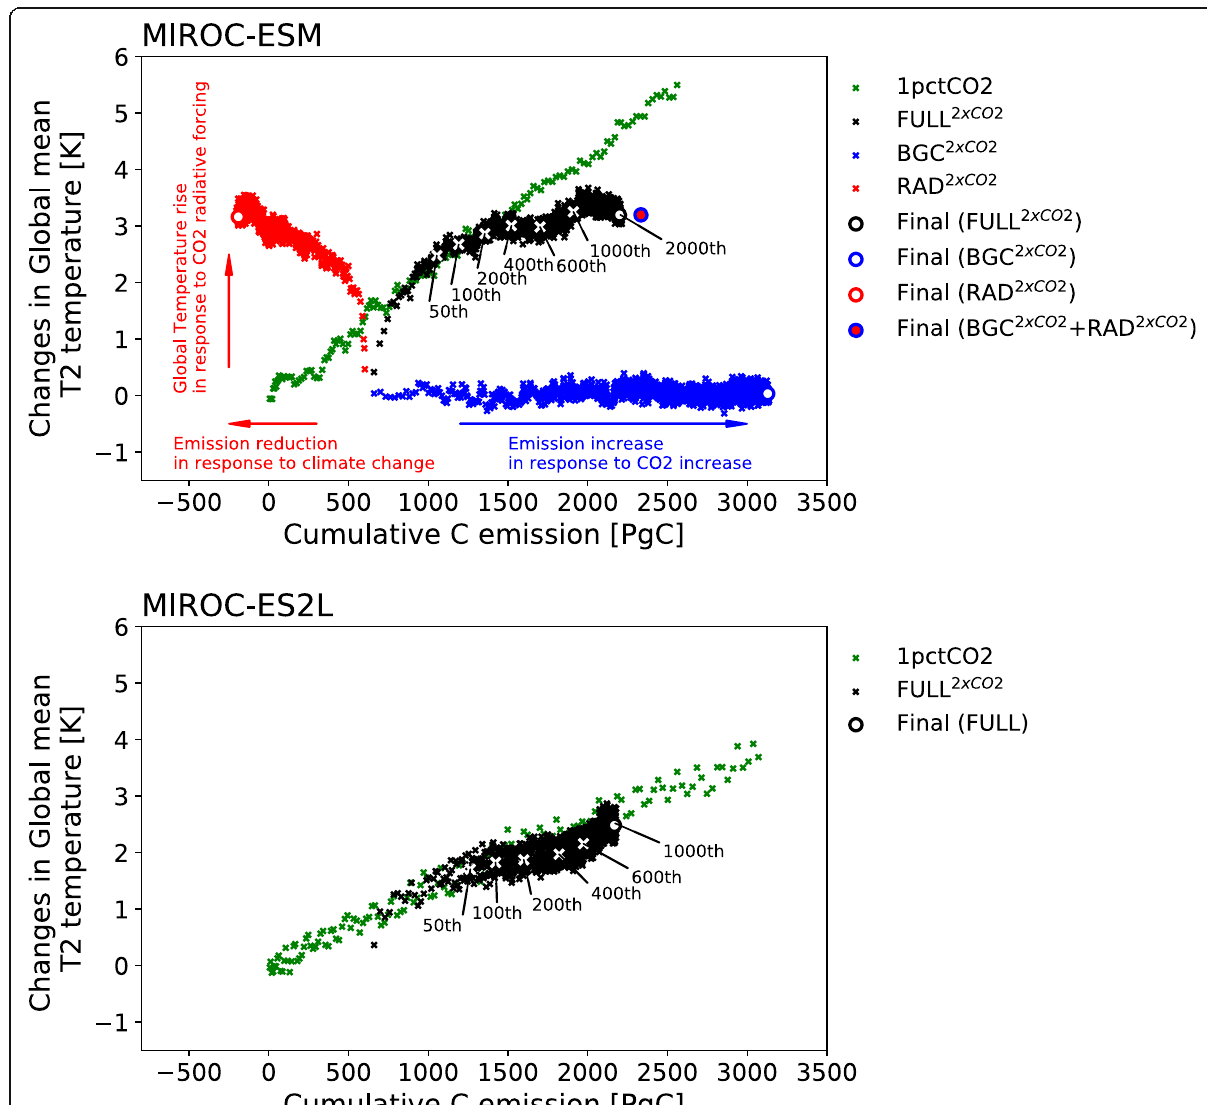
Fig. 3 Relationships between cumulative carbon (C) emission and changes in global mean near surface air temperature in two Earth system models. The top panel presents 2000 year simulations by MIROC-ESM; FULL 2 × CO2 (black), BGC 2 × CO2 (blue), and RAD 2 × CO2 (red) experiments where the CO 2 concentration is abruptly doubled. The result from the 1pctCO2 experiment is shown in green. The bottom panel presents 1000 year simulations by MIROC-ES2L with the FULL 2 × CO2 configuration, together with the result from the 1pctCO2 experiment. Circles presents the final condition of experiments (the last 50 year average). Transient conditions in the Xth year (50 year average centering on the Xth year) are presented by cross marks in